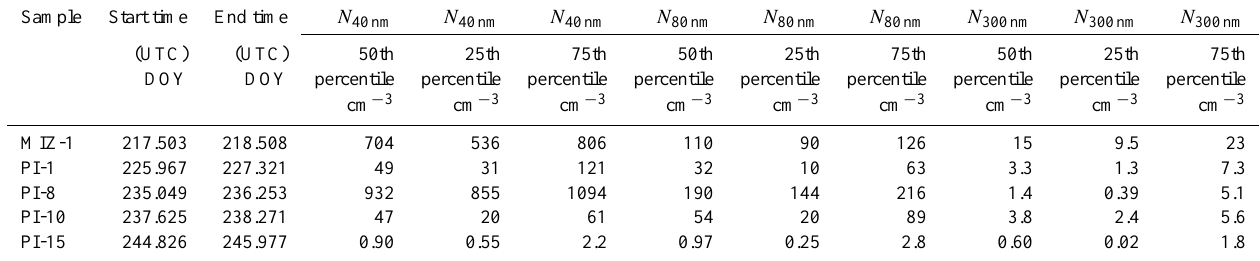
Table 1. The 25th, 50th (median) and 75th percentile aerosol number concentrations seen by the TDMS for 40, 80 and 300nm diameter sizes separately for the impactor samples at the marginal ice zone (MIZ-1) and over the pack ice (PI-1, 8,10, 13 and 15). Values are at STP. Also listed is the information on sampling start–stop times of the